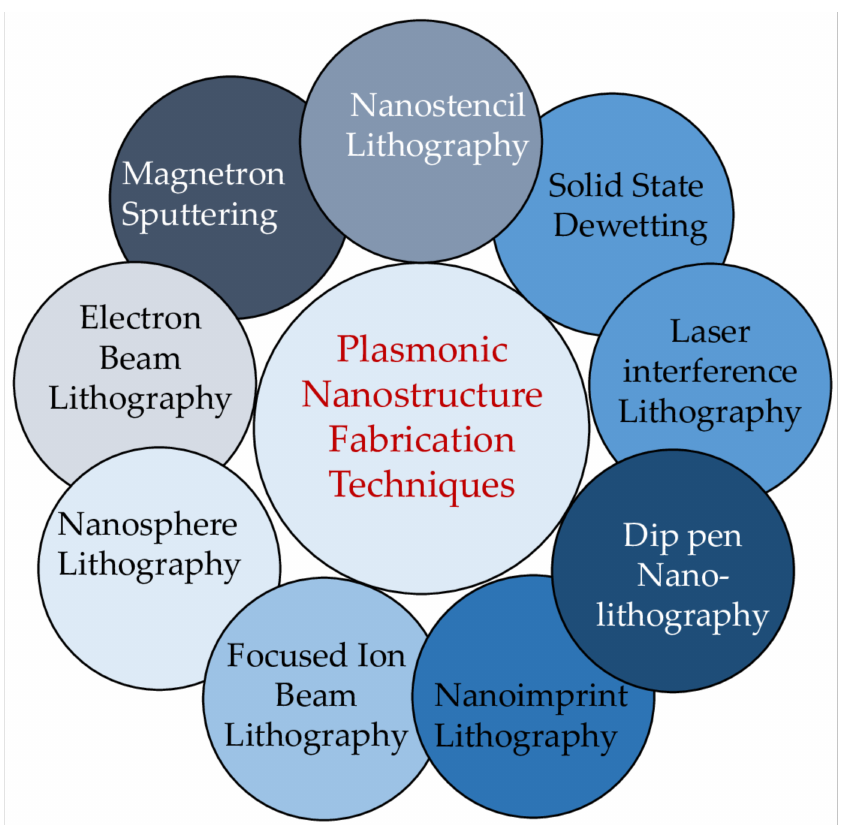
Figure 6. Plasmonics nanostructure top-down fabrication